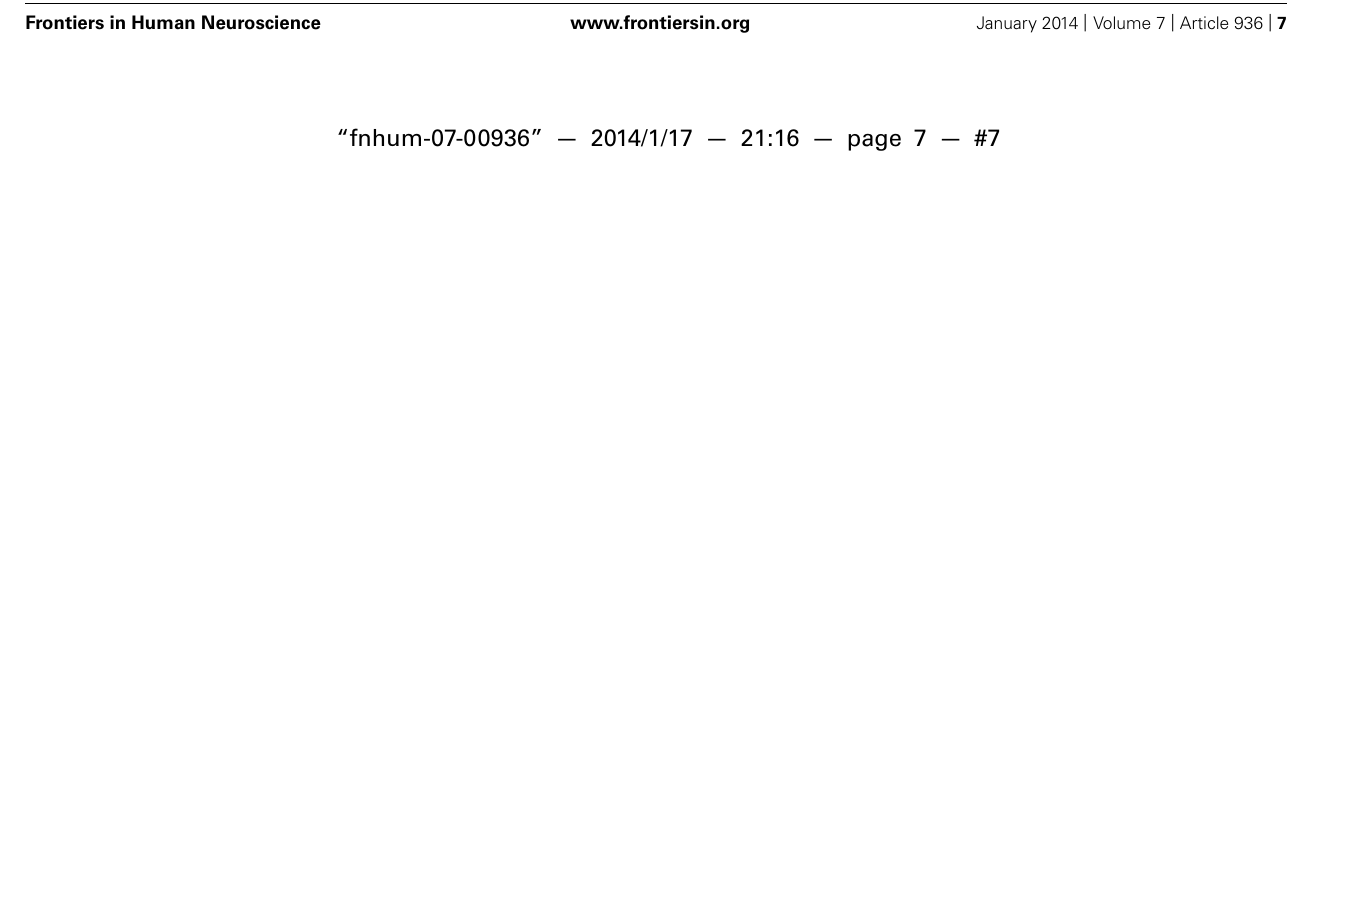
between SPN amplitude and reaction time (RT) of the judgments for expected social acceptance (C) and social rejection (D) feedback. An increase in SPN amplitude during expected social rejection was associated with a significant increase in RT of the corresponding judgment. * p <